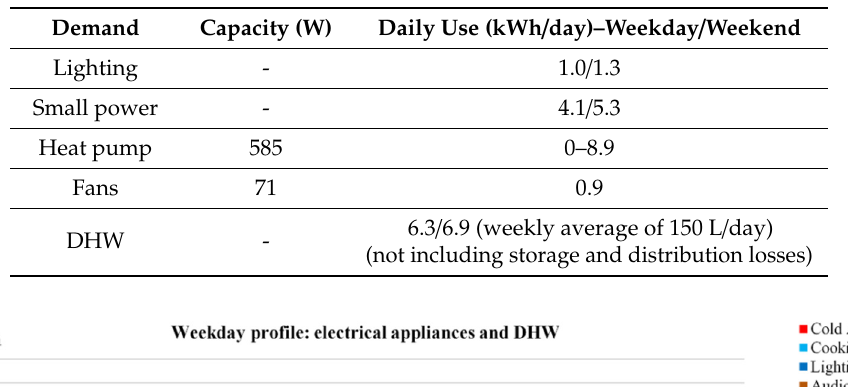
Table 7. Electricity and domestic hot water (DHW) system capacities and demands.